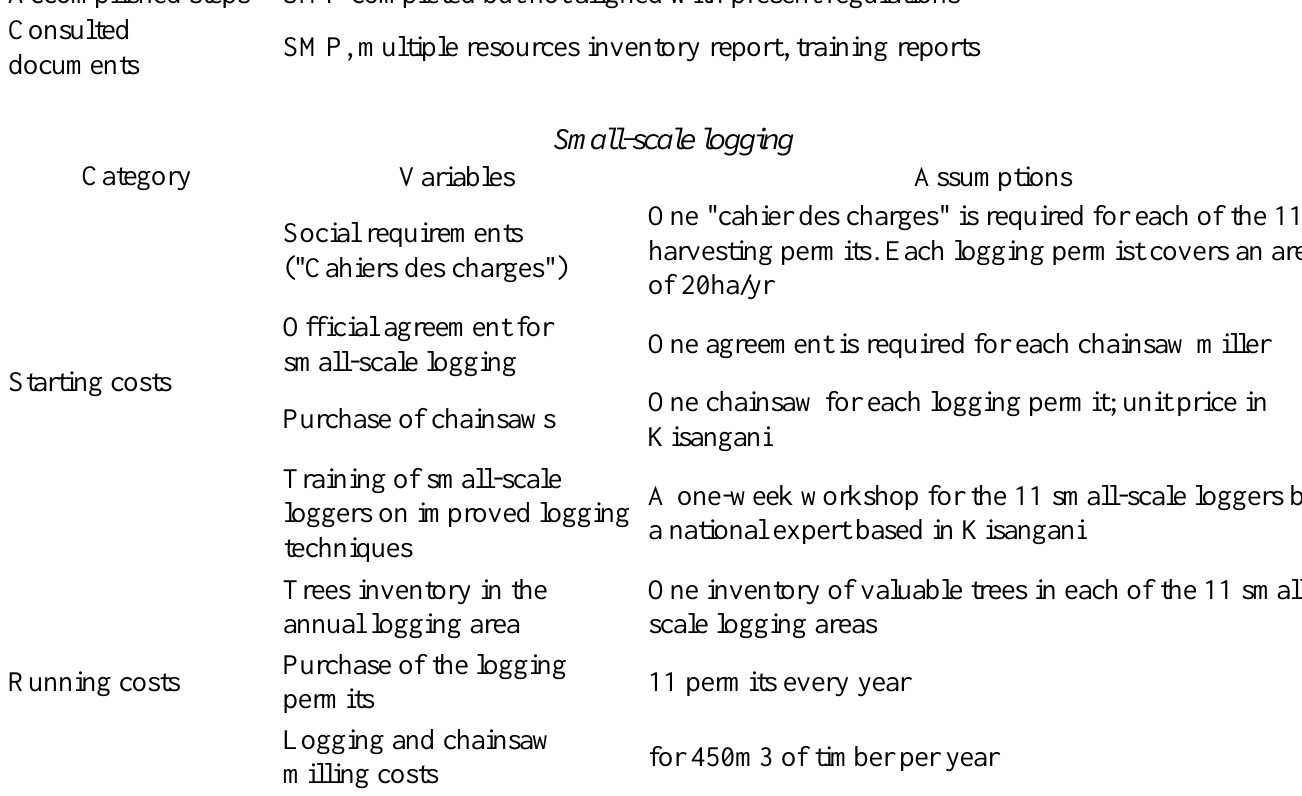
Table A1.1: Variables and assumptions used for the cost-benefit analysis of the LCFC of Lolwa